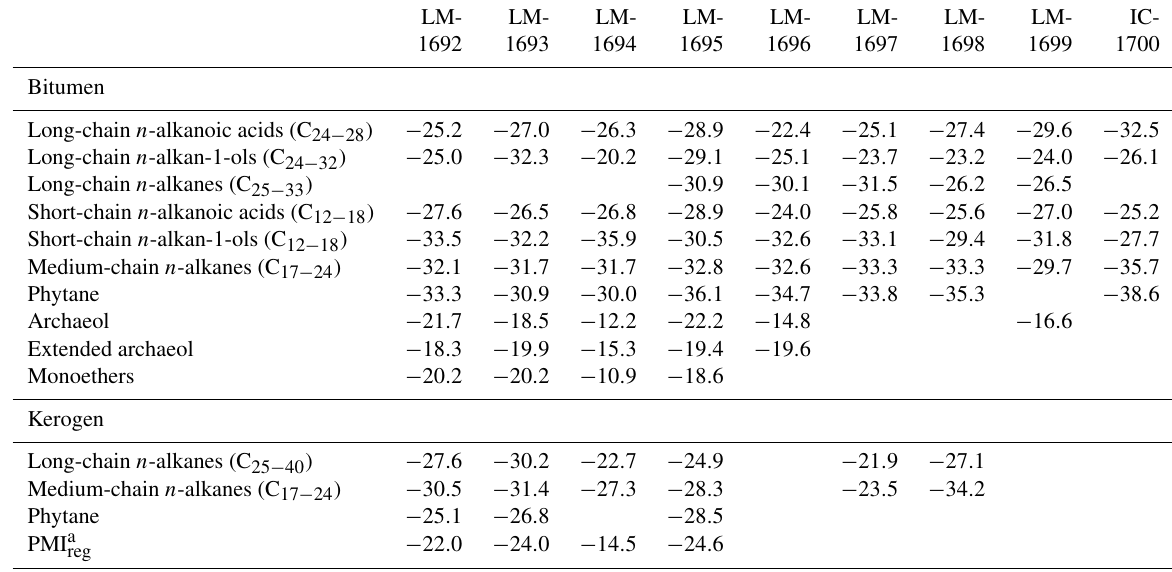
Table 4. Mean δ 13 C V-PDB values in per mil (‰) of key compound classes and selected biomarkers in bitumens and kerogens. LM- LM- LM- LM- LM- LM- LM- LM-